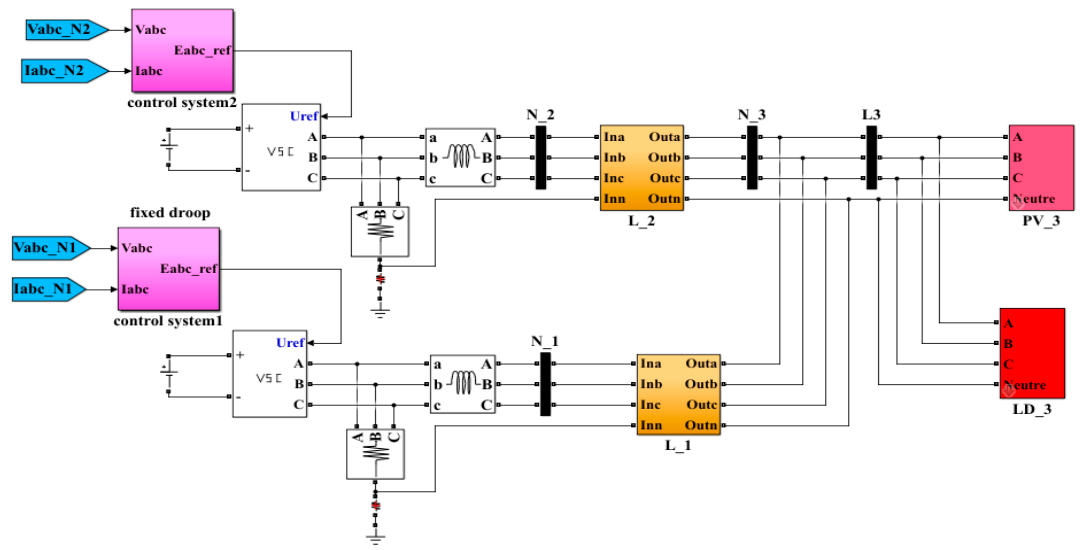
Figure 8. Model of the 3-bus test system in simulation.